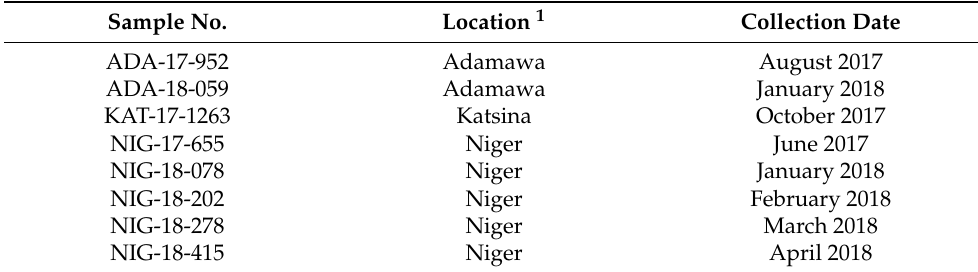
Table 1. Details of water samples analyzed. Sample